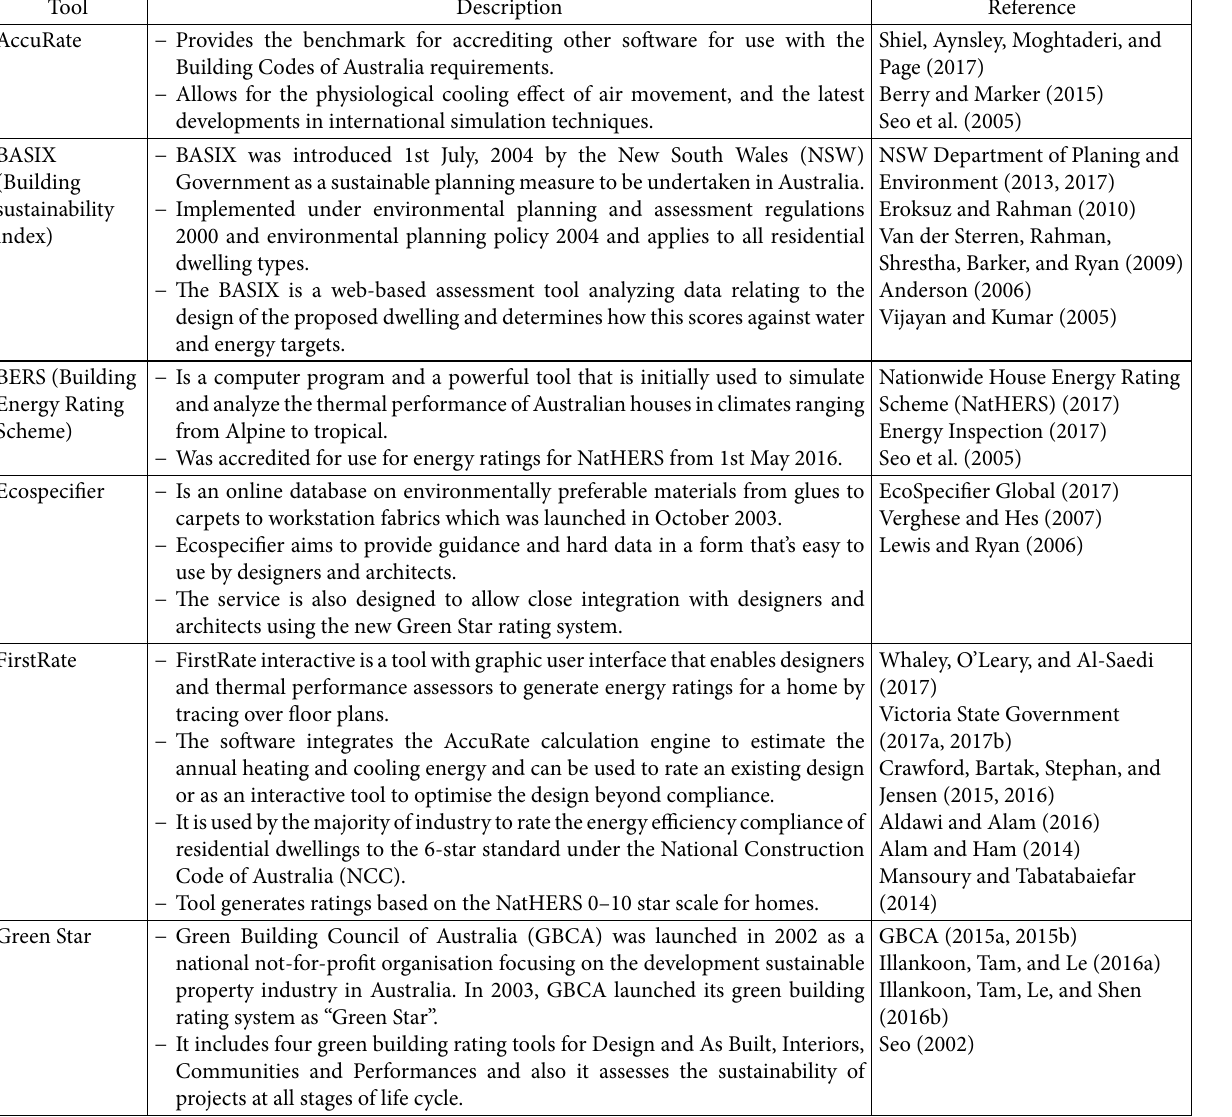
Table 2. Green building rating tools used in